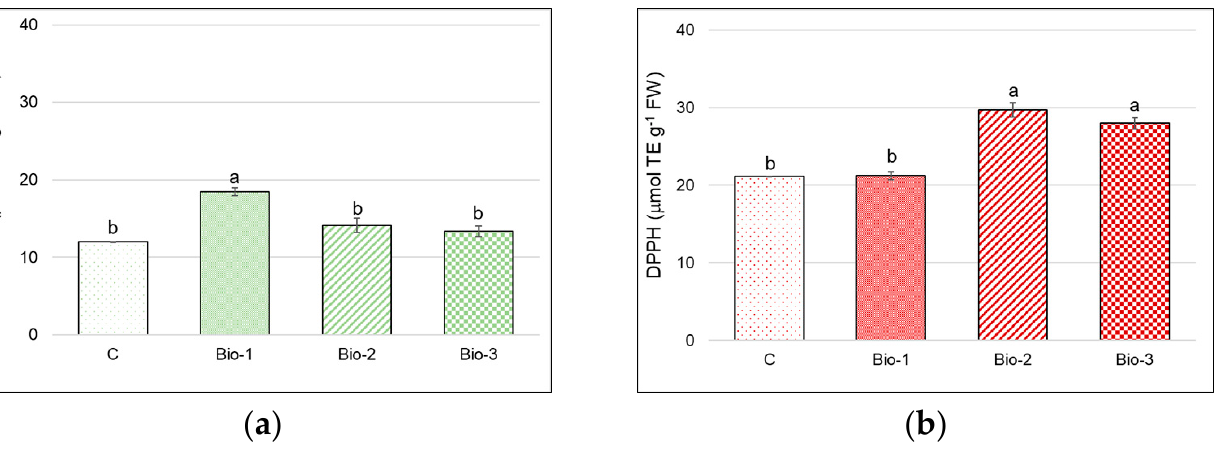
Figure 7. Effect of biostimulants (Bio-1 = TRAINER ® ; Bio-2 = AQUAMIN, and Bio-3 = Moringa oleifera leaf extract) on the antioxidant activity (DPPH radical scavenging) (µg TE g − 1 FW) in turnip greens ( a ) and radish ( b ) microgreens. Data are means ± se ( n = 3). Different letters indicate significance at p ≤ 0.05 according to the LSD test.